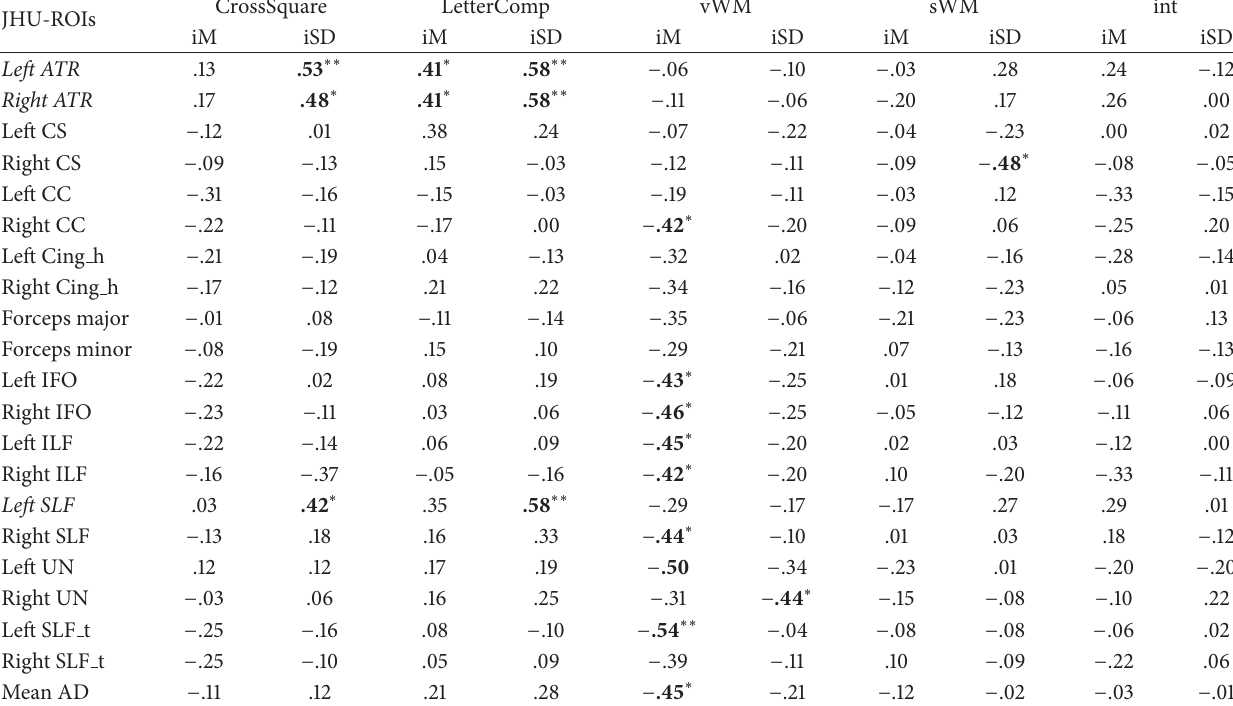
Table 6: Correlations between AD in the JHU-ROIs and cognitive